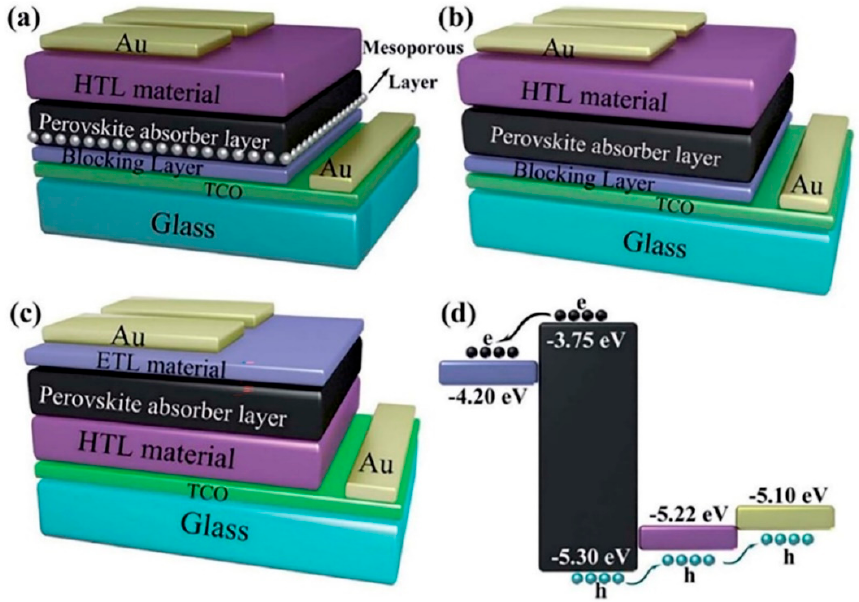
Figure 1. Structural configurations of perovskite solar cells: ( a ) mesoporous structure, ( b ) planar heterojunction structure, ( c ) inverted planar heterojunction structure, and ( d ) schematic diagram of electron and hole transportation [15]. Copyright 2018 Royal Society of Chemistry.